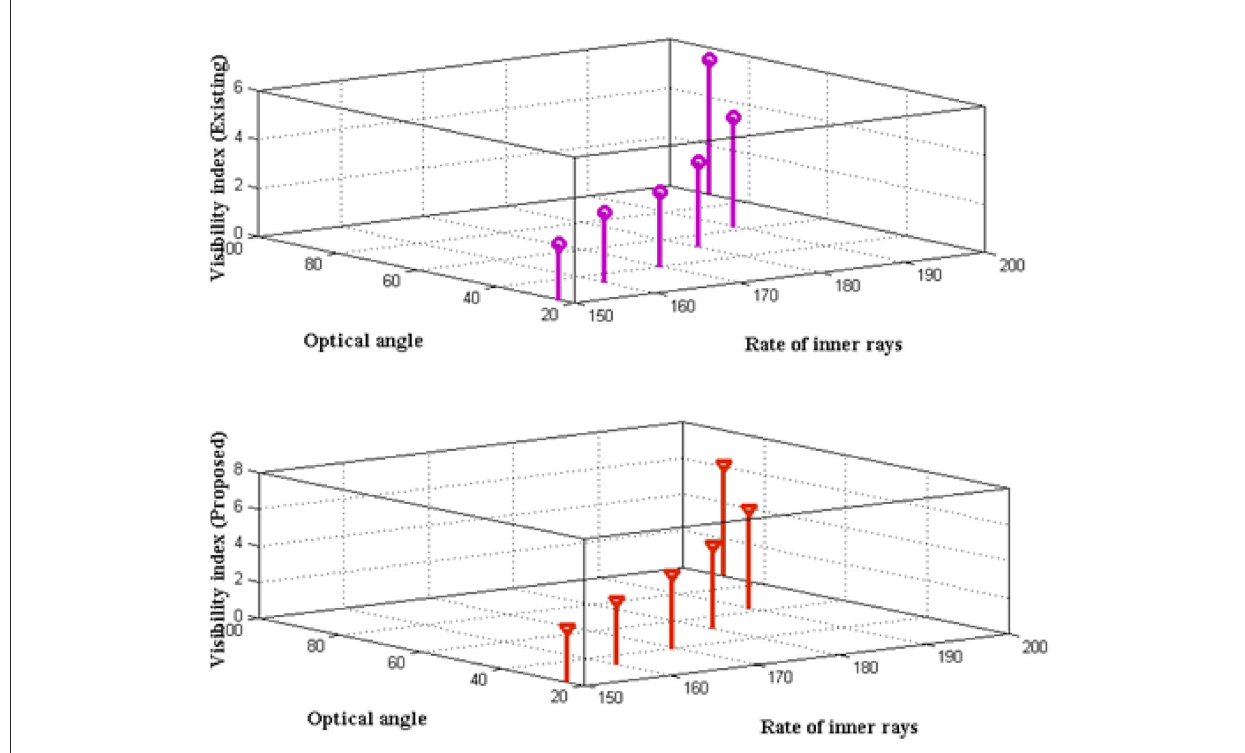
FIGURE2 Visibility pattern beside inner rays.